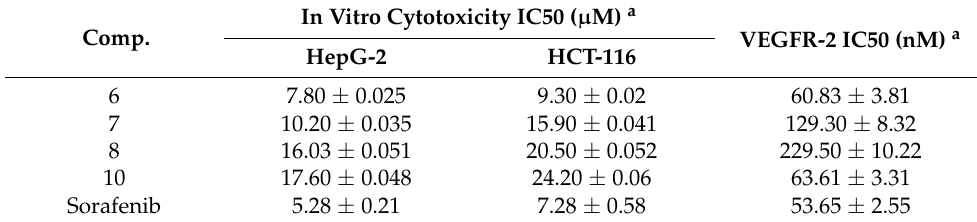
Table 1. In vitro cytotoxic and VEGFR-2inhibitory potentialities. Comp.